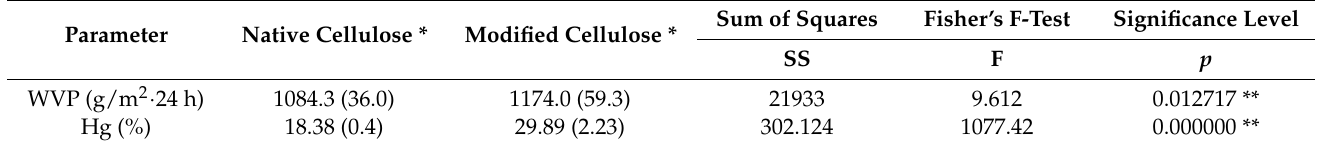
Table 2. Water vapor permeability (WVP) and hygroscopicity (Hg) of native and modified cellulose.